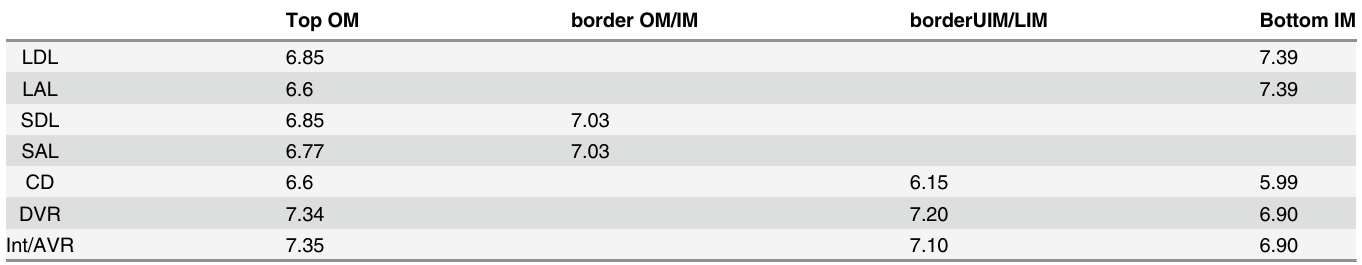
Table 7. pH gradients assumed in the